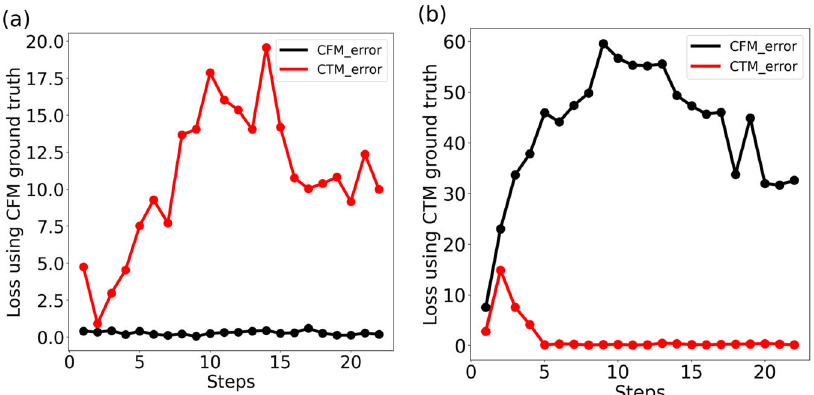
Fig. 3 The model fi tting loss comparation. The loss comparation of the CFM and CTM model fBO fi tting using different theoretical standard real spectrum: a CFM theoretical standard real spectrum; b CTM theoretical standard real spectrum. npj Computational Materials (2023)